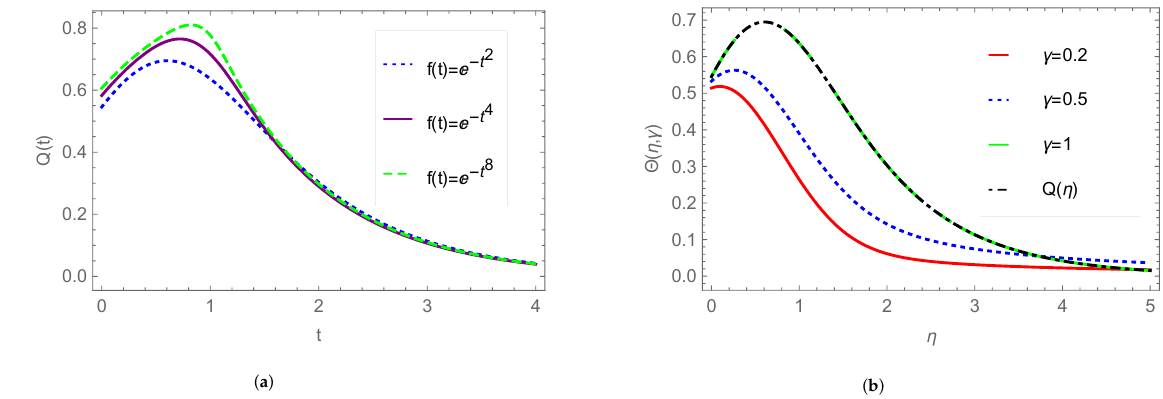
Figure 9. Solution Θ γ ( t ) with different f ( t ) and γ values. ( a ) Ordinary circuit (40) with different f ( x ) , Gaussian or Super- Gaussian; ( b ) Comparison between fractional and ordinary circuits for Equation (57), with f ( η ) = e − η 2 , for different values of γ , and Equation